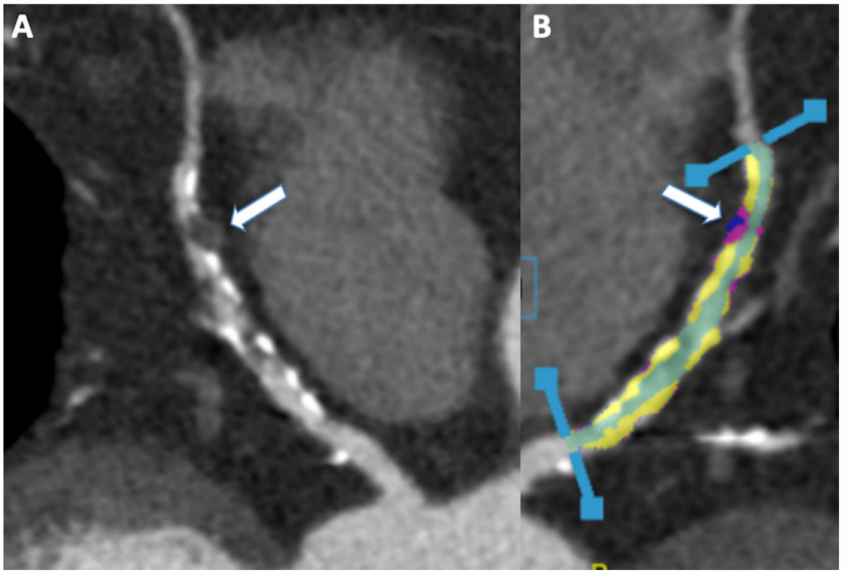
Figure 5. ( A ) 55 year old male patient showing diffuse coronary artery disease on left anterior descending artery (panel ( A )). The predominant plaques were calcified, a fibro-fatty plaque with positive remodeling was observed on mid-LAD (arrow, ( A )). Plaque analysis confirm huge coronary calcification (yellow, ( B )), while fibrofatty and remodeled plaque (arrow, ( B )) show fibrofatty plaque (purple) associates with necrotic core (blue).